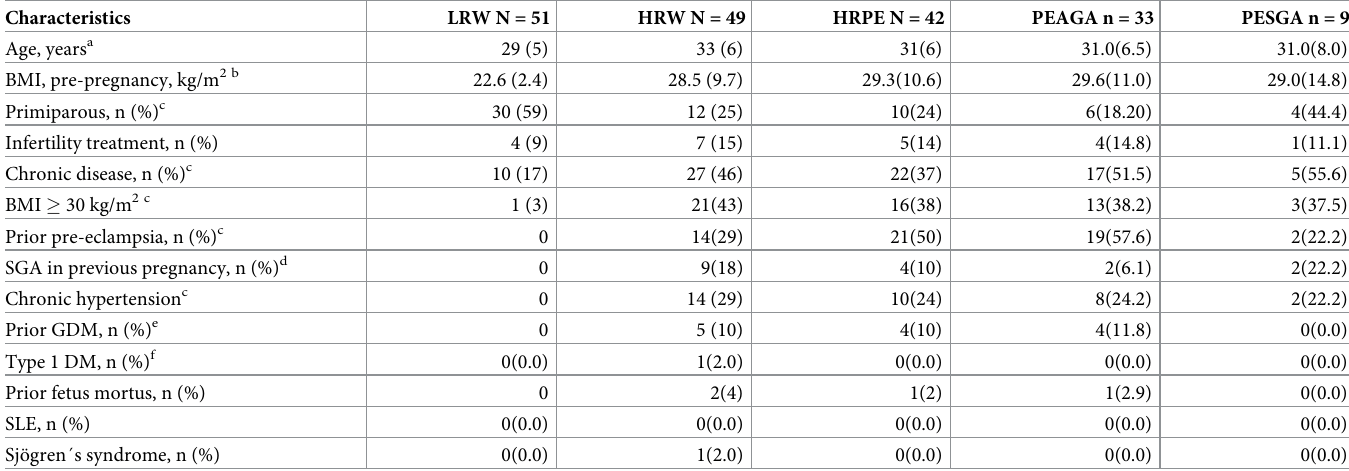
Table 2. Baseline characteristics of study